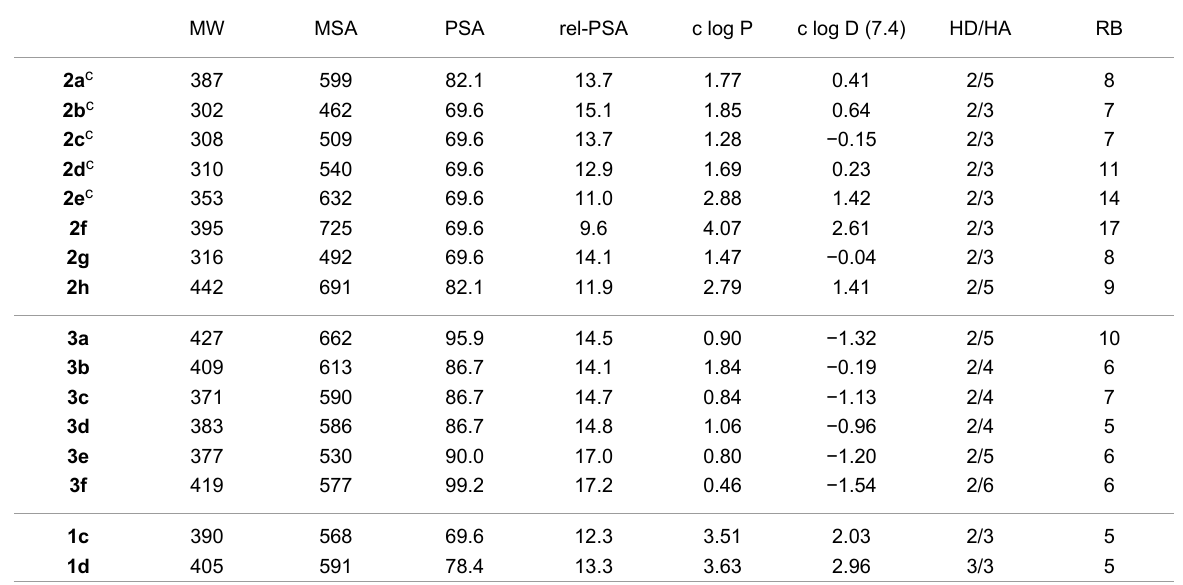
Table 3: Physicochemical properties of 3-carboxamide tetramic acids. a,b